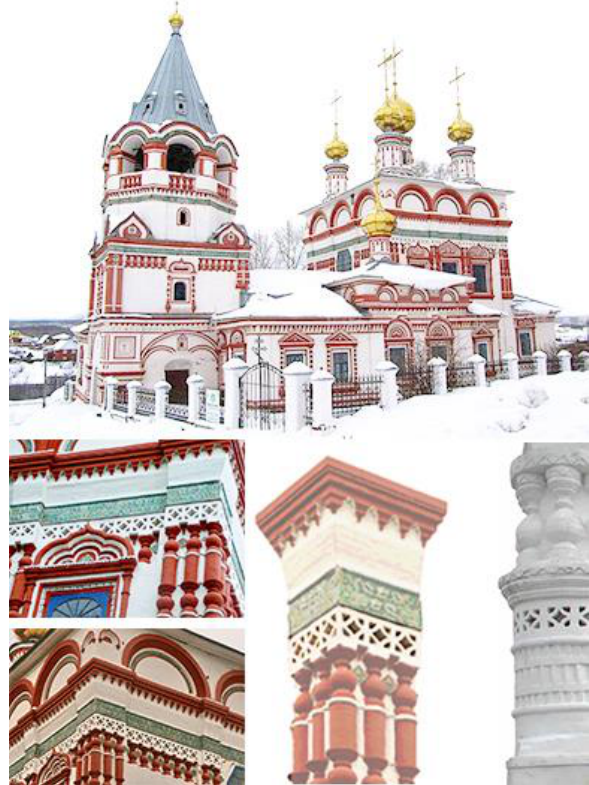
Figure 3. The Tserkov church (Solikamsk) an example of the use of the “zjuchkoviy” (Ж - Жучковый